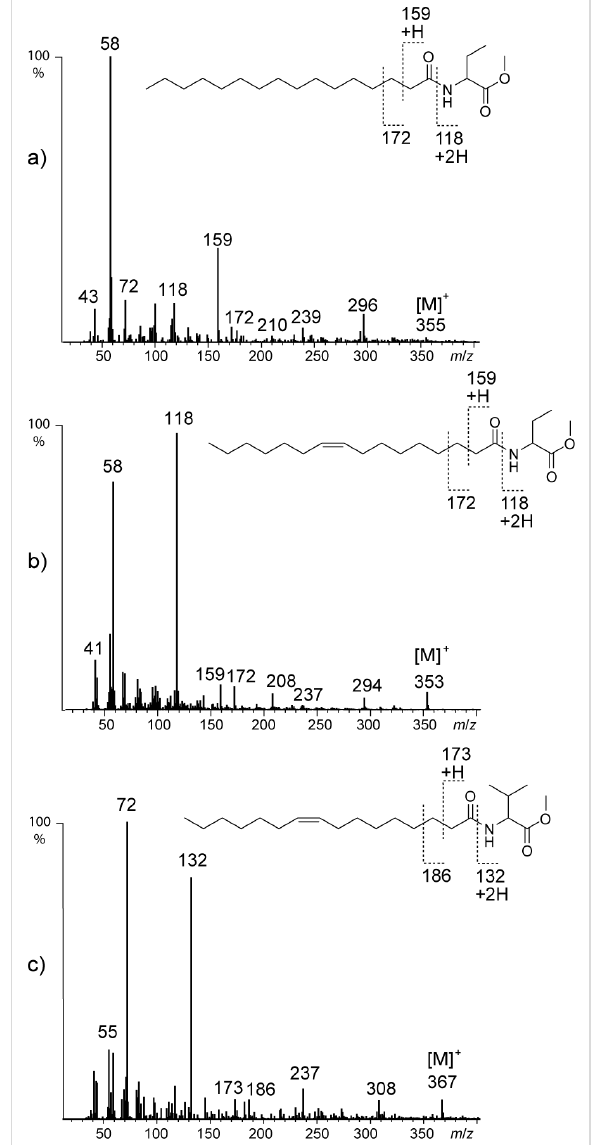
Figure 4: Mass spectra of natural compounds a) K ( 7 , C16:0-NABME), b) J ( 8 , C16:1-NABME), and c) N ( 9 , C16:1-NAVME).